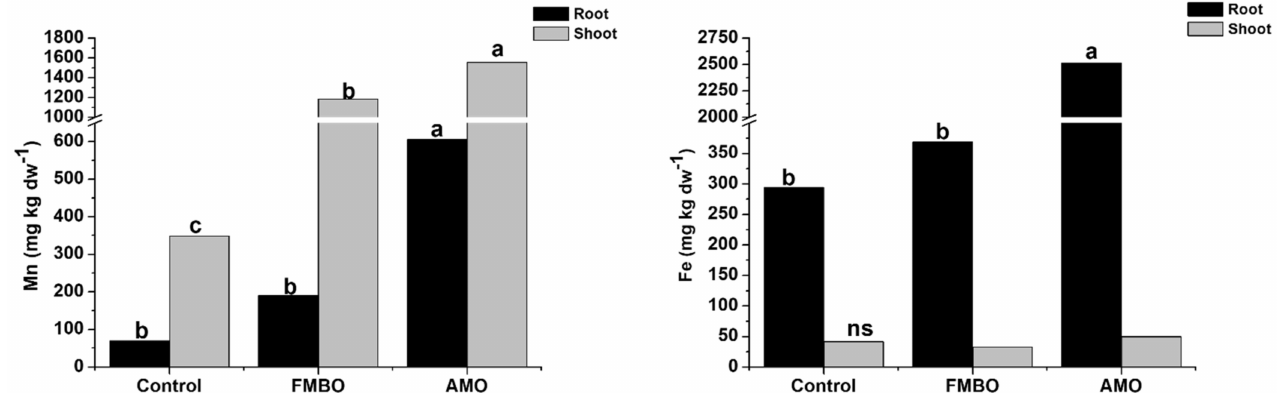
Figure 7. Iron (left) and Mn (right) contents (mg kg dw − 1 ) in shoot and roots of white lupin plants after 35 DAT. For each series different letters denote significant differences among the NMOs according to Duncan’s Test ( p < 0.05).